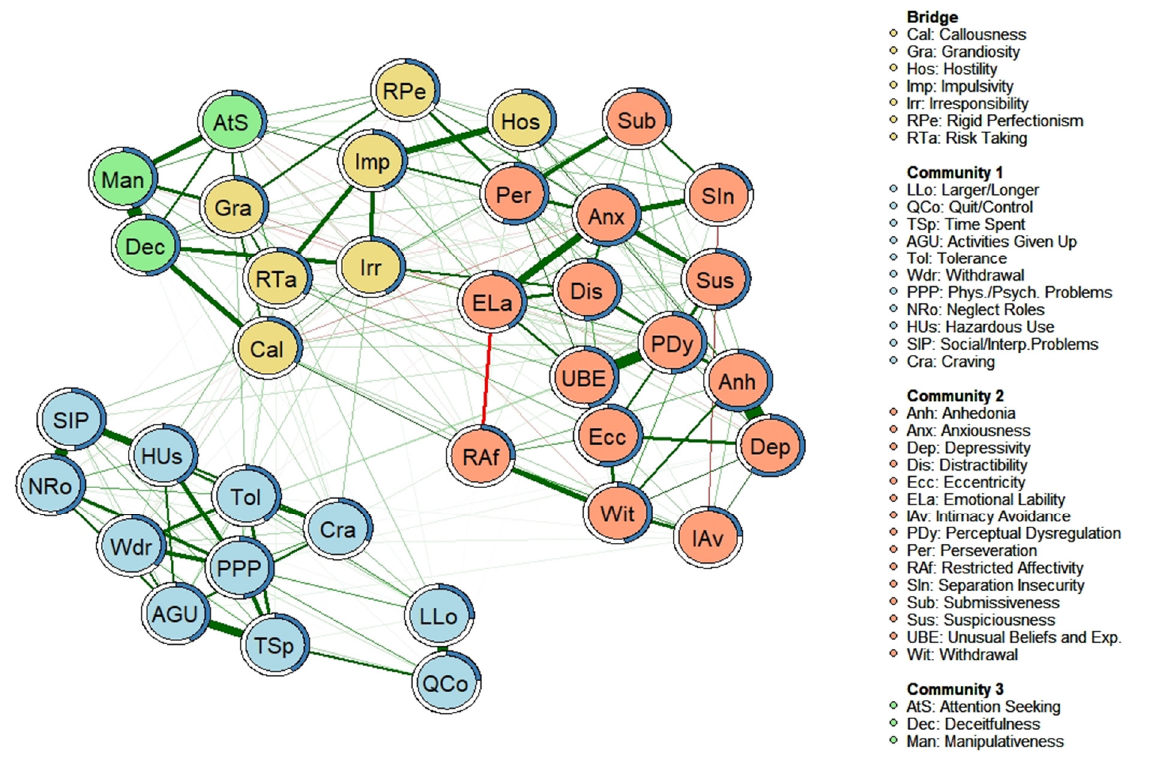
Figure 2. Empirical network model (network structure estimated from a walktrap modularity analysis) and bridge nodes for complete sample ( n = 985). Note. Each node represents a symptom. The edges represent the relationships (partial correlations) between the symptoms. Positive relationships are represented in green. and negative relationships in red. The thickness of the edge reflects the strength of the association, so the most strongly related symptoms are connected by thicker edges. The blue pie chart surrounding each node represents the predictability of each node (a higher proportion of blue indicates greater predictability). The membership of the nodes to the different communities is represented by different colors: bridge symptoms are shown in yellow; the symptoms of Community 1 are shown in blue; the symptoms of Community 2 are shown in salmon; and the symptoms of Community 3 are shown in green. The arrangement of the nodes was established based on the Fruchterman-Reingold